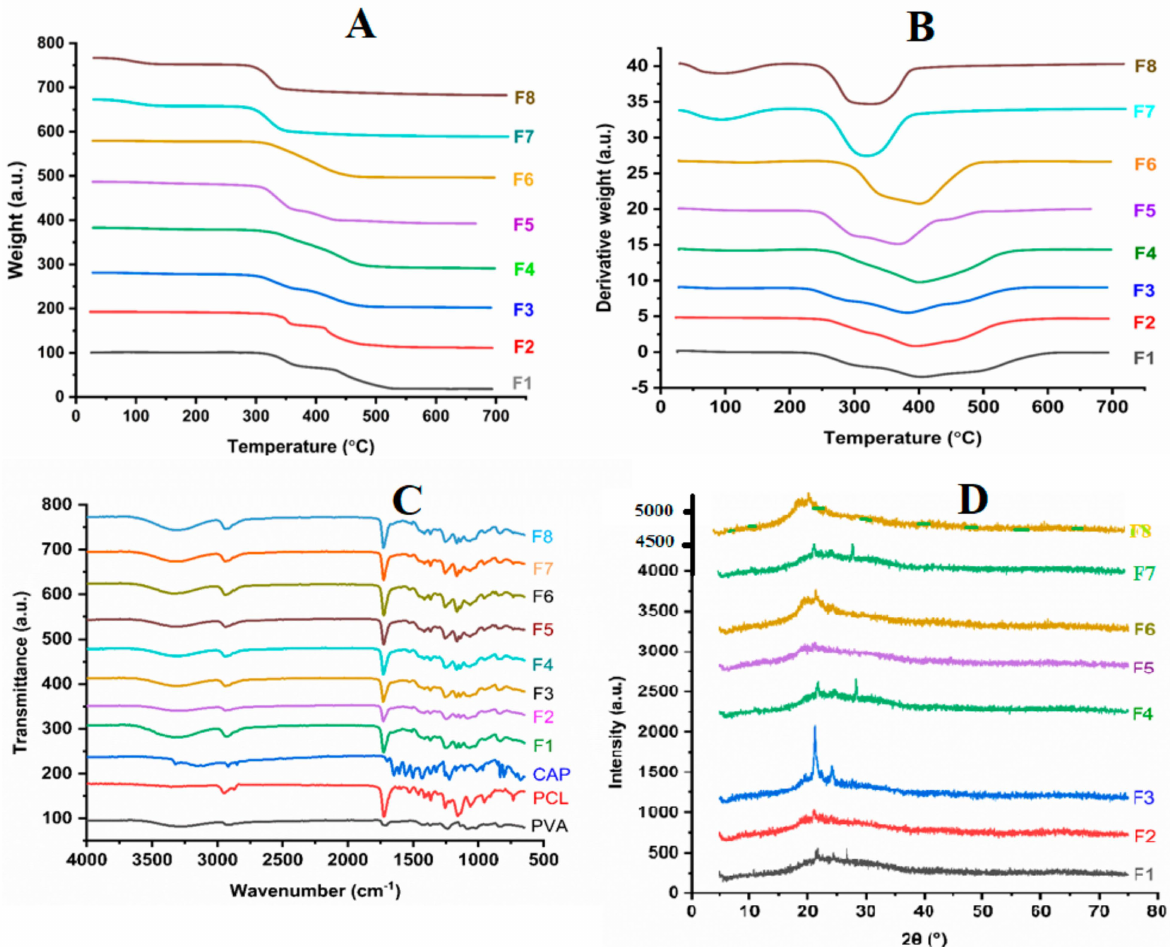
Figure 2. Morphological characterization of the electrospun scaffolds using ( A ) TGA, ( B ) DTA, ( C ) FTIR, and ( D )